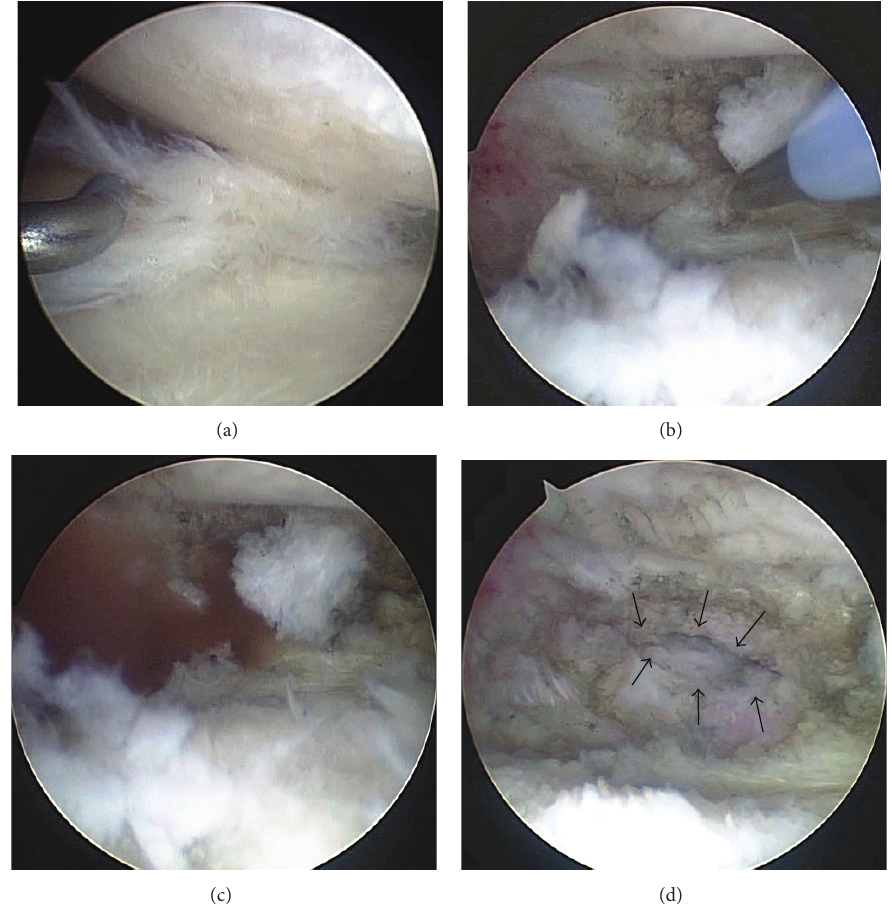
Figure 2: Arthroscopic views of the medial meniscus. (a) Degenerated horizontal tear of the middle and posterior segments was identified. (b) An introducer needle was inserted at the most peripheral site to the torn meniscus. (c) Massive bloody viscous fluid exploded from the small channel between the upper and lower leaf of the torn meniscus with disappearance of the medial large mass. (d) A small channel is indicated by arrows.